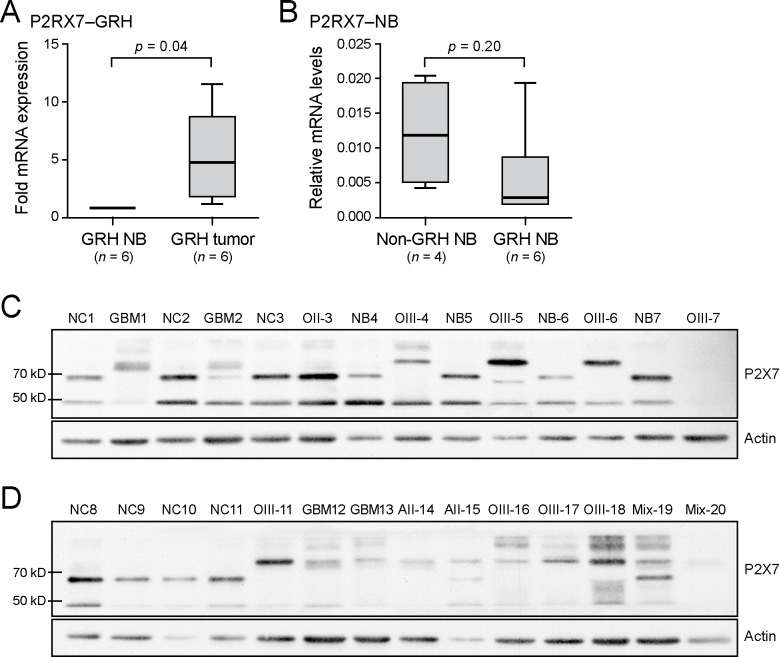
Expression of P2RX7 in canine gliomas.(A) Quantitative RT-PCR comparing matched GRH normal brain (nominally 1.0) to GRH tumor tissue and (B) comparing normal cerebrum from GRH and non-GRH tissue. P2RX7 mRNA expression using primers recognizing the majority of known splice variants is significantly elevated in gliomas (A). Western blotting of P2RX7 in matched normal cerebrum and tumors (C) and non-matched normal and tumor (D) showing consistently higher molecular weight bands for gliomas compared to normal brain. NC = normal cerebrum, GBM = glioblastoma, O = oligodendroglioma, A = astrocytoma, NB = normal brain (cerebrum) matched to tumor sample, Mix = Oligoastrocytoma.